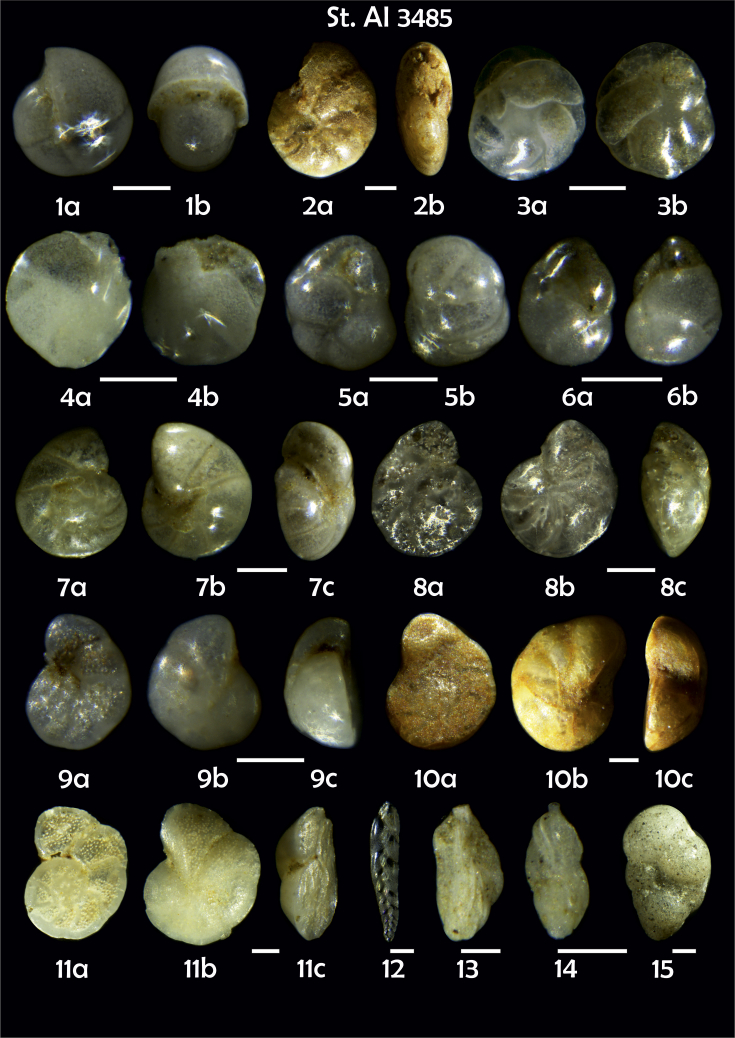
Station 34851Pullenia bulloides, a side view, b apertural view. 2 ?, a lateral view, b apertural view. 3Cassidulina teretis, a apertural view, b lateral view. 4C. laevigata, a, b lateral view. 5Globocassidulina subglobosa,a apertural view, b lateral view. 6G. subglobosa,a lateral view, b apertural view. 7Gyroidina orbicularis, a spiral view, b umbilical view, c apertural view. 8Cibicidoides sp., a umbilical view, b spiral view, c apertural view. 9, 10Cibicides refulgens, a umbilical view, b spiral view, c apertural view.11Cibicidoides lobatulus, a umbilical view, b spiral view, c apertural view. 12Bolivina earlandi. 13, 14Trifarina angulosa. 15Eggerella bradyi. Scale 100 μm.